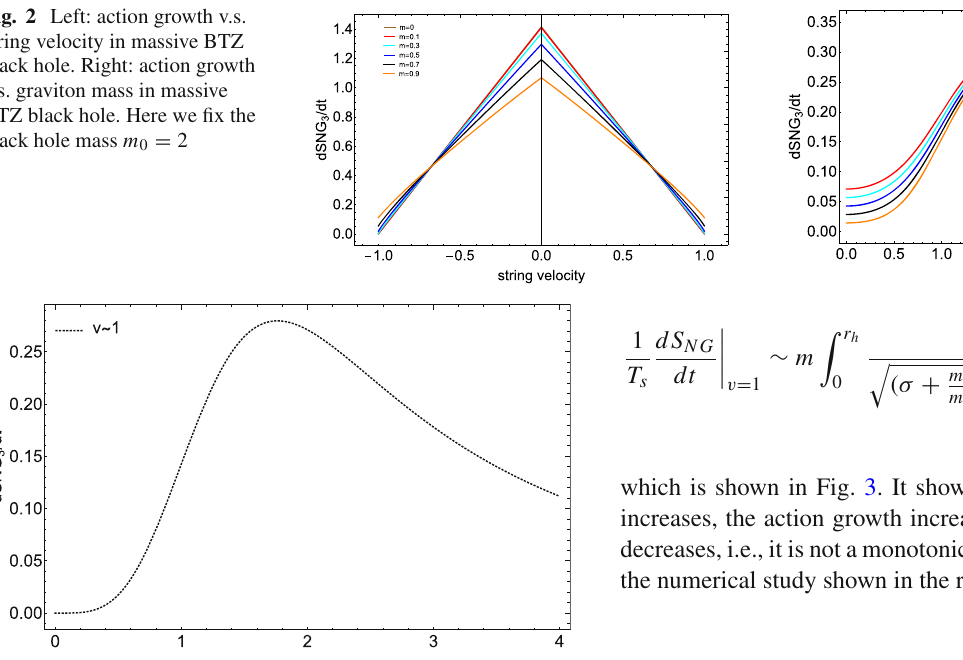
Fig. 3 Action growth v.s. graviton mass in massive BTZ black hole. Here we fix the black hole mass m 0 = 2 and v ∼